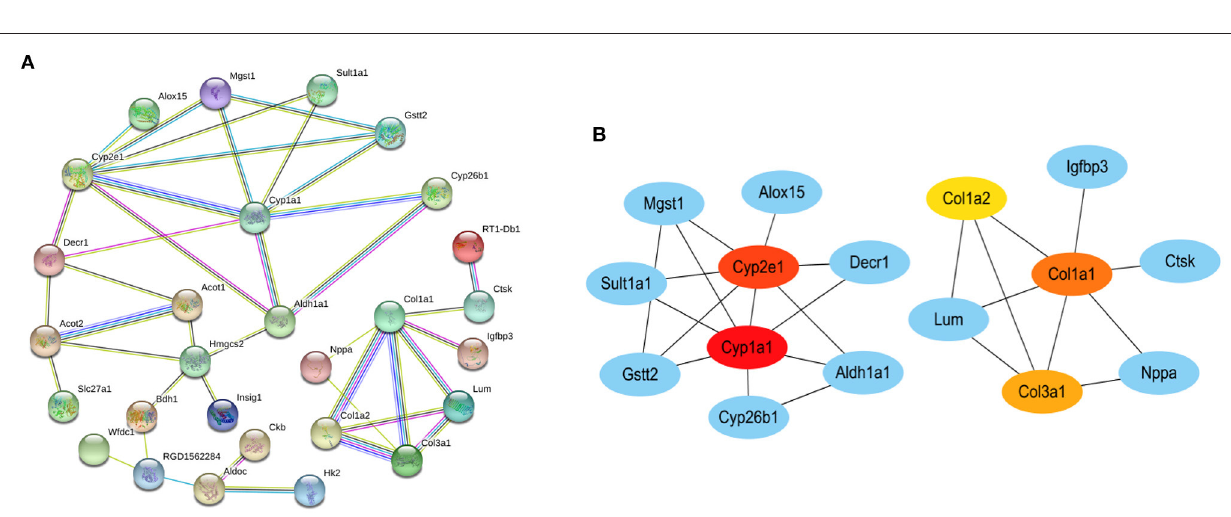
( Figures 8J,K ). However, we observed positive correlations in both groups between Cyp2e1 and LVAWs ( Figure 8L ). In addition, correlations between Cyp1a1 mRNA levels and fasting glucose in non-diabetic and diabetic mice were also shown in Supplementary Figure 4